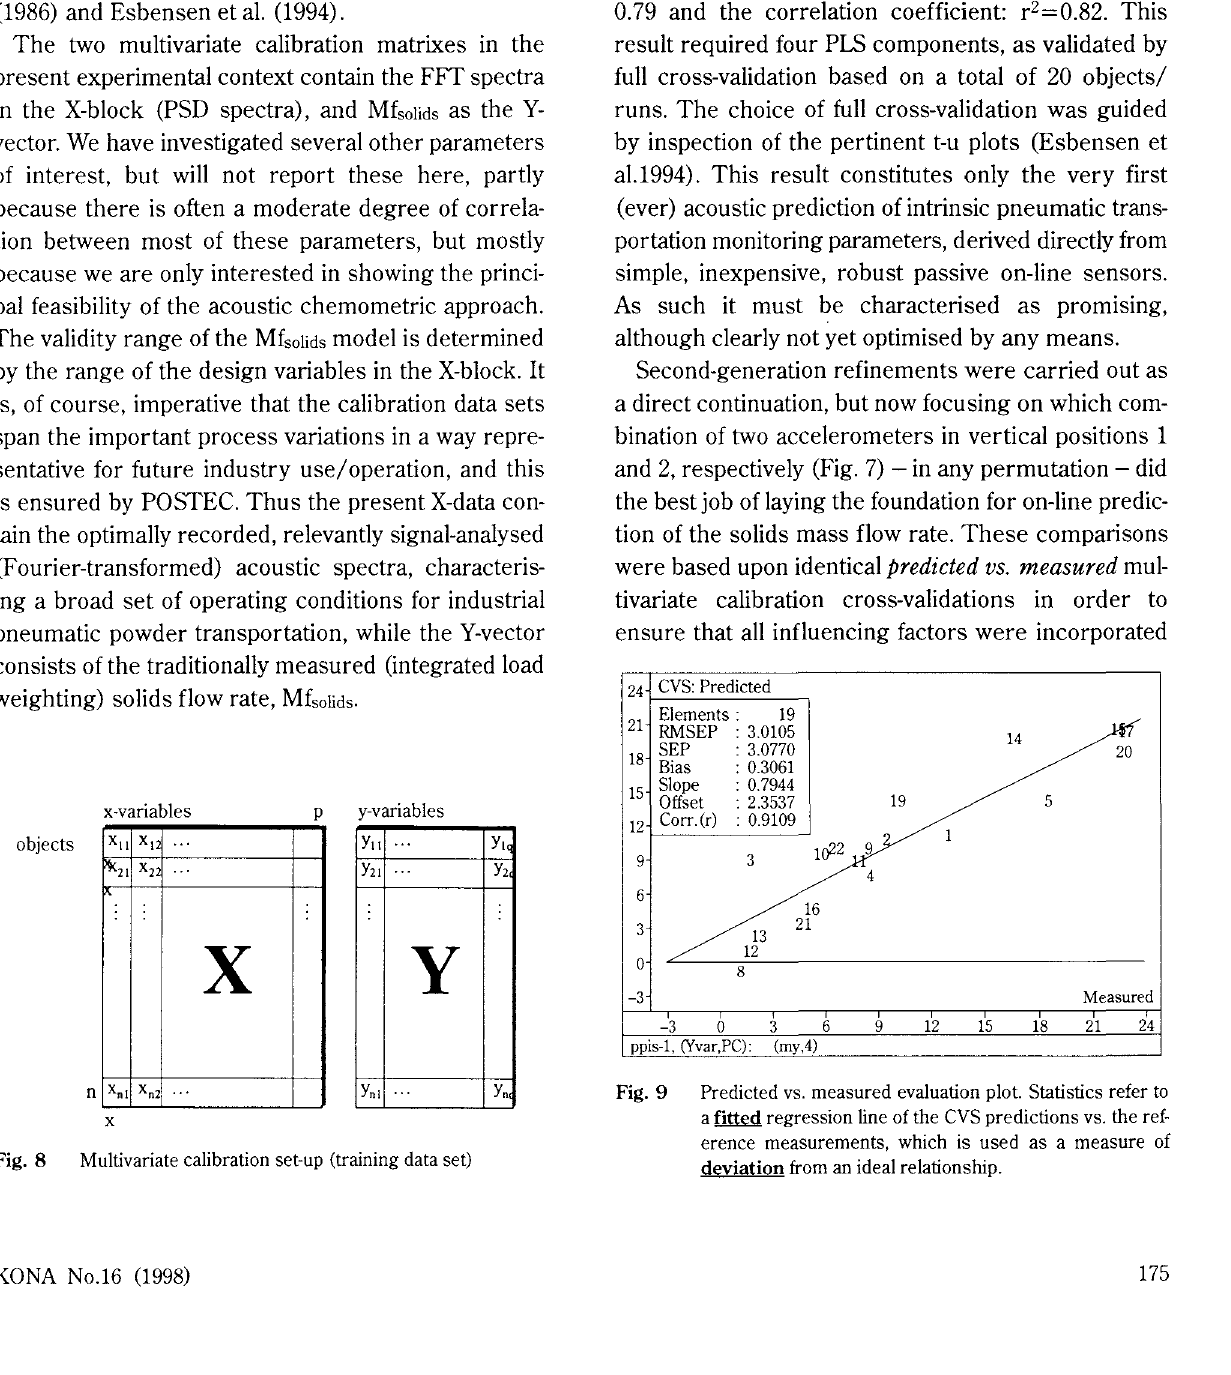
Fig. 8 Multivariate calibration set-up (training data set)